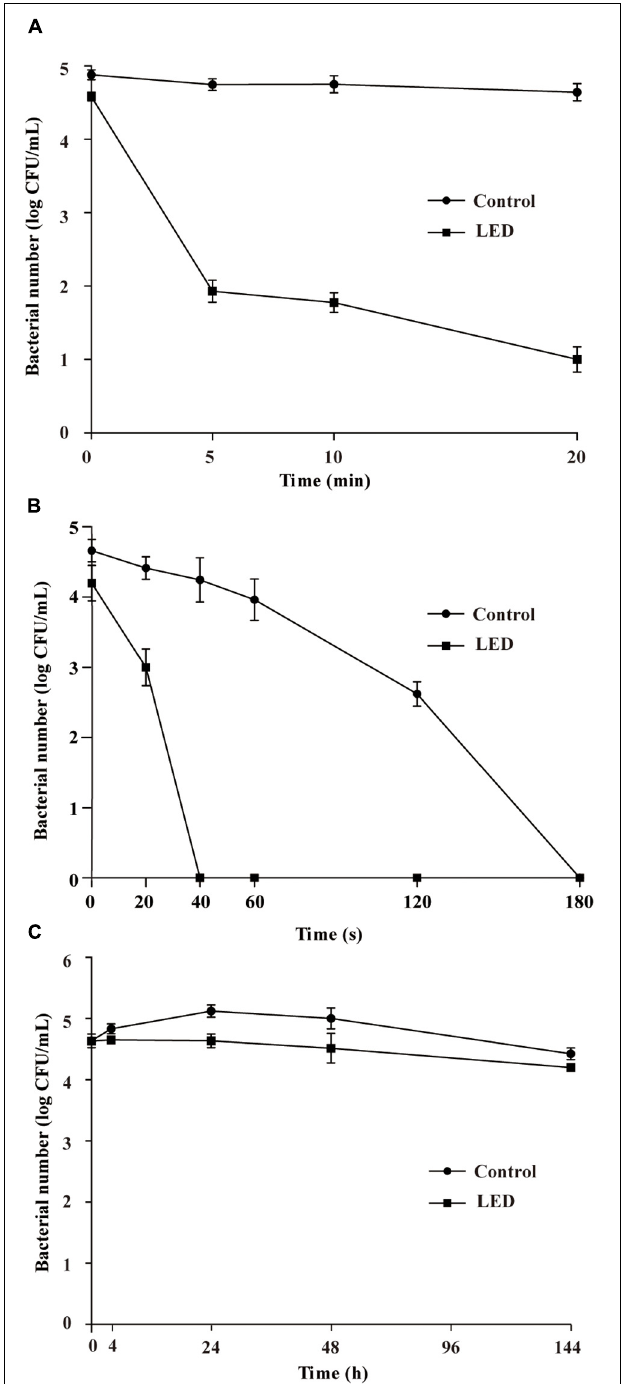
FIGURE 2 | Survival of LED-illuminated and unilluminated L. monocytogenes cultures in 0.04% H 2 O 2 (A) , under UV irradiation (B) , and at 4 ◦ C (C)